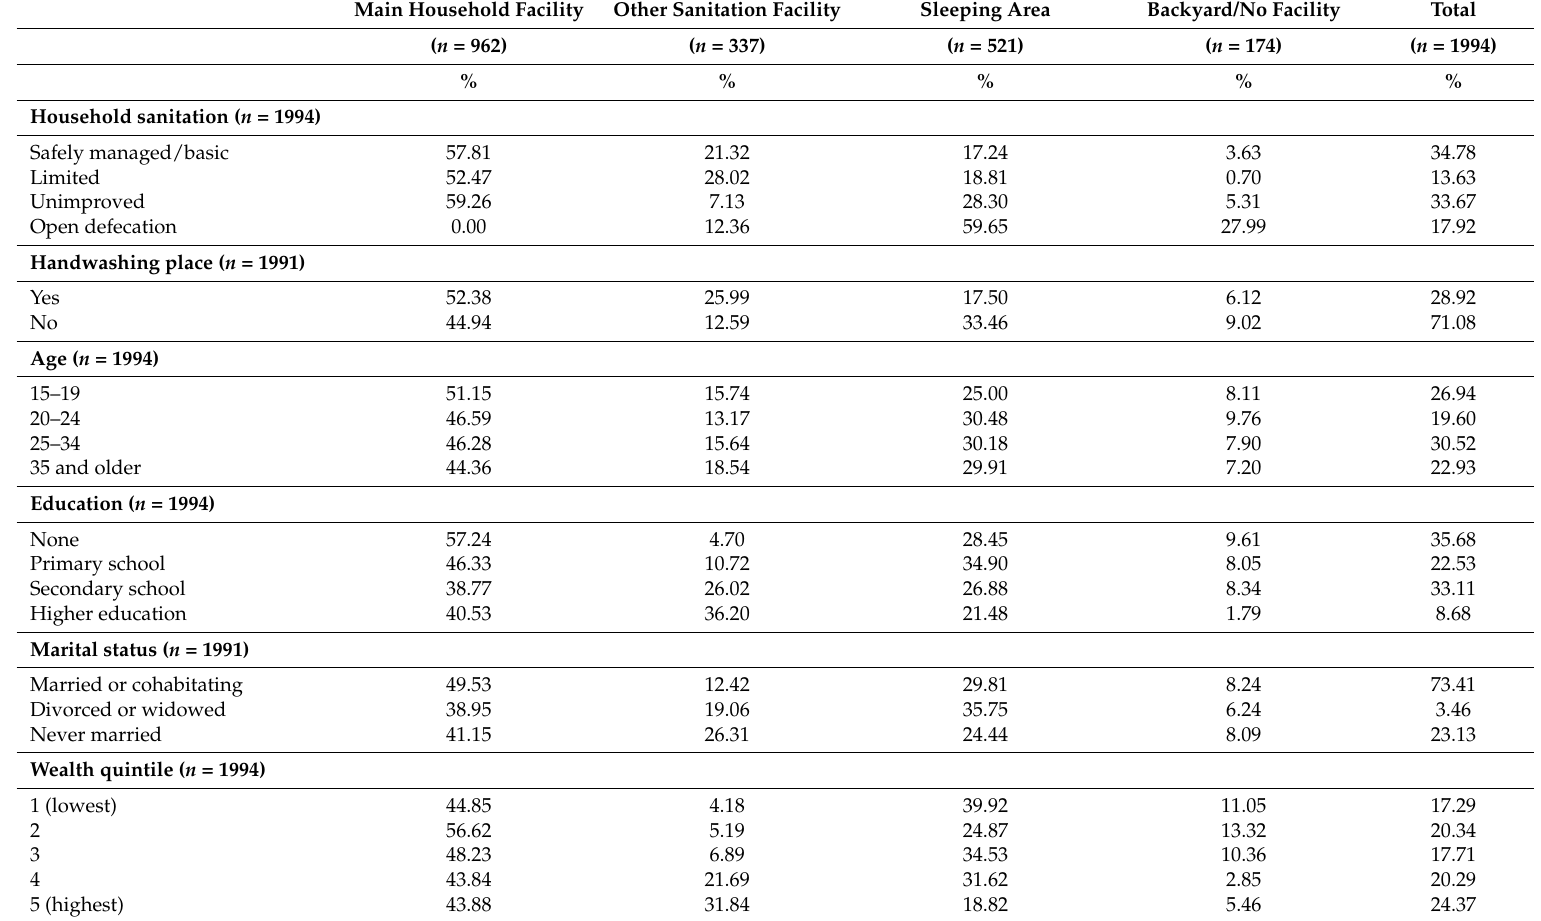
Table 1. Sample characteristics according to the location of menstrual